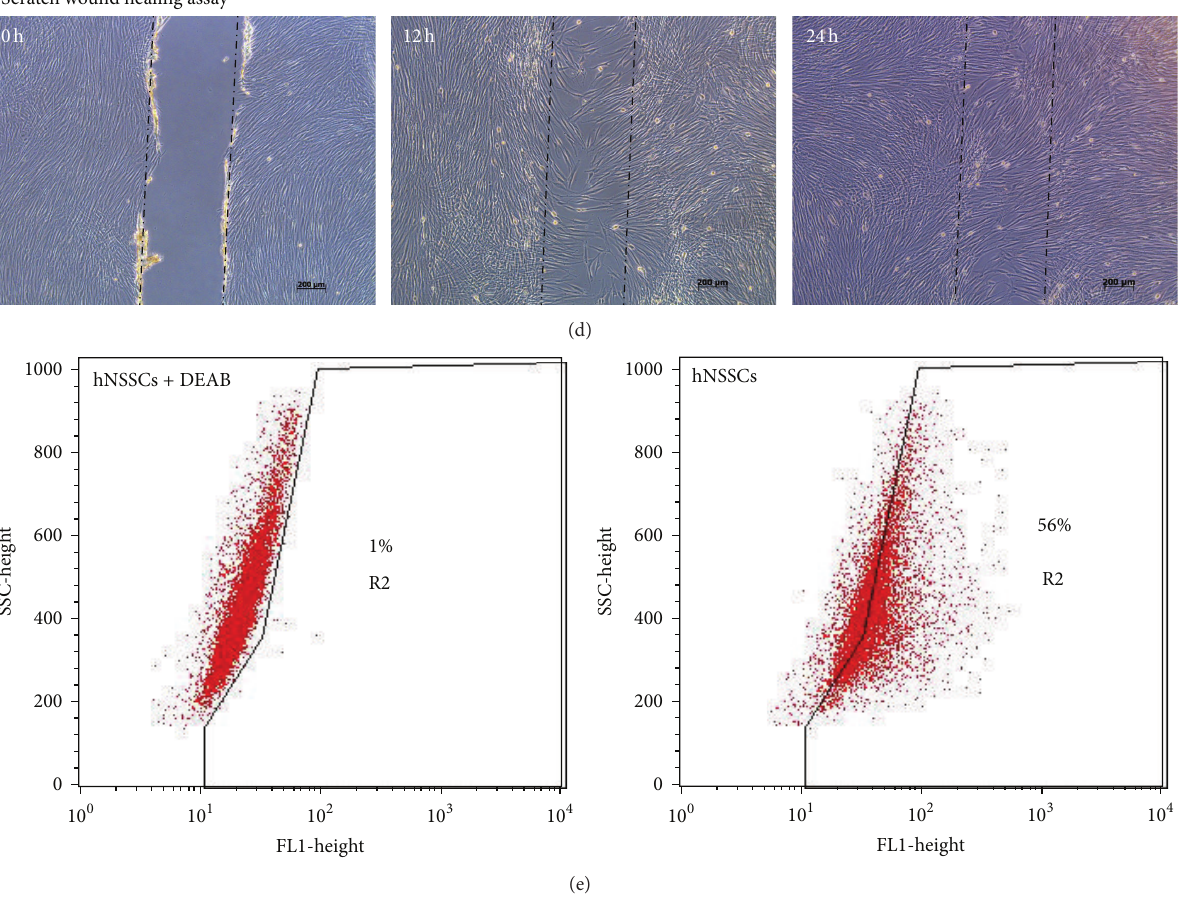
Figure 1: Explant organ culture system of neonatal foreskin. (a) Cell migration from skin tissue after 3 days (left); fibroblast-like cells can be observed migrating and sprouting out from tissue after 12 days (right). (b) A transwell migration assay where cells migrated to the lower chamber visualized by Eosin staining. The transwell migration assay was repeated and the total number of cells that migrated was quantified to determine the relative numbers of migrated cells (b, lower panel). Data are presented as mean ± S.D. The experiment was run in triplicate. (c) The real time migration was executed using the xCELLigence RTCA DP device. Cells were seeded per well in 16-well microelectronic sensing, two-chamber transwell plates (CIM-plates). The electrical impedance was captured every 15 min for an experimental duration of ∼ 68h. The rate of migration is expressed as the CI or the change in electrical impedance at each time-point (c, left). Values are expressed as the ± SEM of the 8 replica wells from three independent experiments (c, right). (d) Measurement of undifferentiated hNSSCs cell migration by in vitro wound healing scratch assay. The migration ability was assessed 12 h and 24 h from injury. The figure shows the migration of undifferentiated cells immediately after the scratch 0h, 12h, and 24h (Bar = 100 𝜇 m). (e) ALDH activity of hNSSCs was measured using the Aldefluor assay and FACS analysis. Cells incubated with specific inhibitor of ALDH, DEAB, were used to establish the baseline fluorescence of these cells and to define the Aldefluor positive